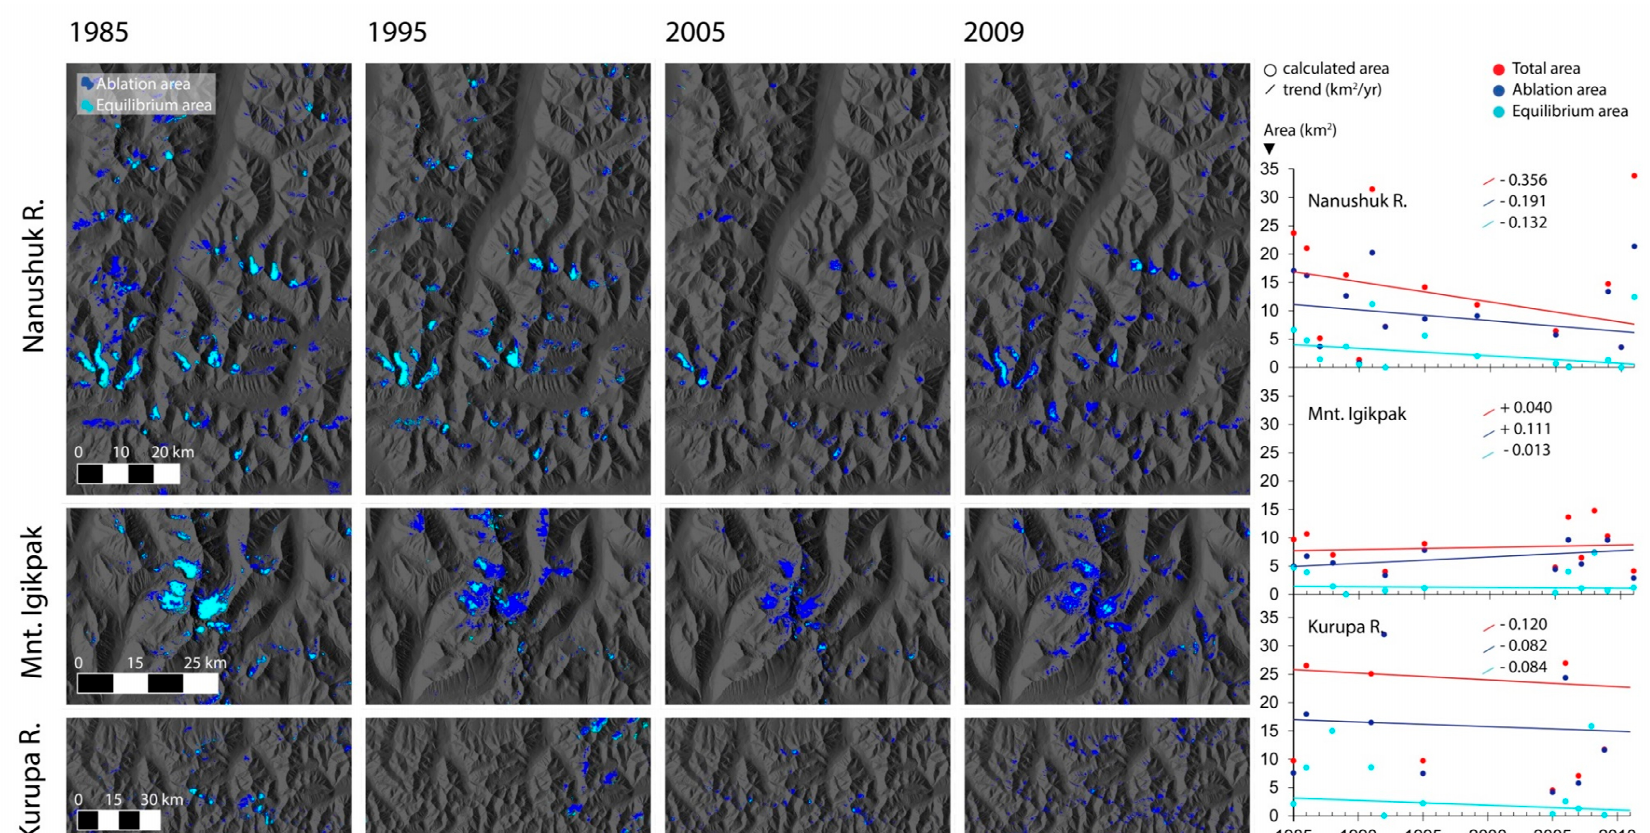
Figure 5. Annual summer season (1 July–15 Aug) perennial snowfield minimum extent time series maps derived from the 30 m scale Landsat 4 and 5 imagery (L4 / L5), showing several example years in the three localized study areas of Nanushuk River, Mount Igikpak, and Kurupa River. The maps depict changes in overall snowfield coverage, as well as changes in equilibrium areas (light blue) and in ablation areas (dark blue). The accompanying graphs show the extent changes in the three study areas quantitatively, including calculated areas for each summer from observed extent changes, as well as trends in the area changes. The trend lines are derived from the nonparametric Mann-Kendall Theil Sen’s statistical approach, for total extent changes, as well as for equilibrium and ablation area changes.